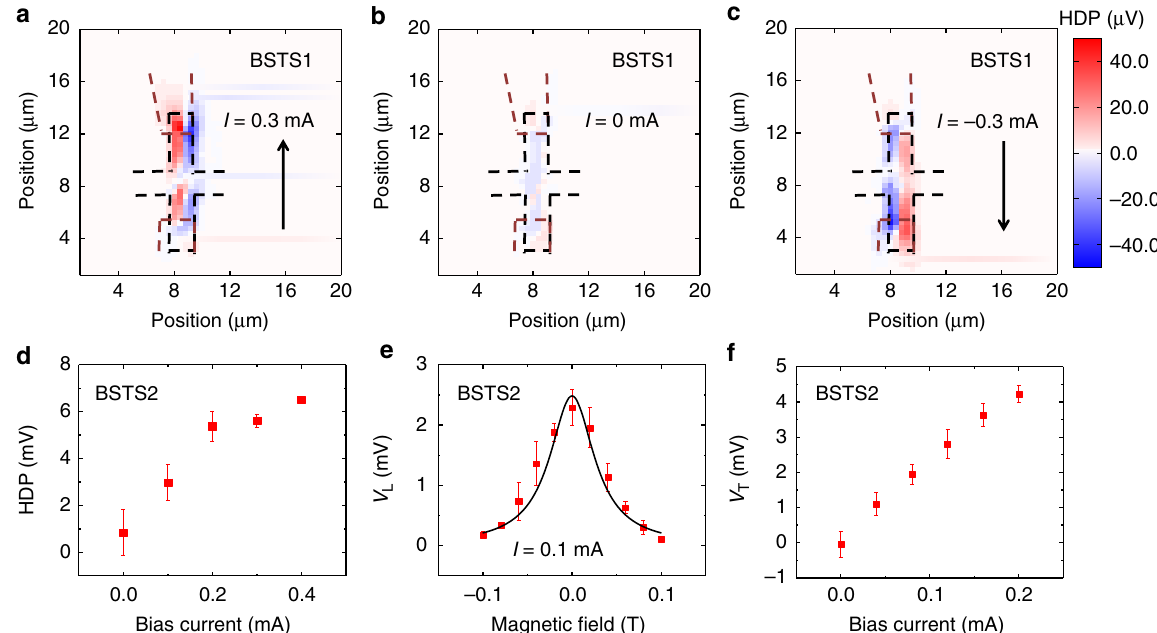
Fig. 4 Current induced spin accumulations in BiSbTeSe 2 . a – c Spatial two-dimensional HDP map in BSTS1 under bias currents of 0.3 ( a ), 0 ( b ), − 0.3 mA ( c ) with I pump = 0.4 mW. Black dashed lines represent the boundaries of the device. Black arrows show the direction of applied bias current. d Bias current dependence of V L by fi xing the laser spot at one edge of the device in BSTS2. e Measurement of HDP at one edge as a function of B ext in BSTS2. f Bias current dependence of V T by fi xing the laser spot at the center of the Hall cross in BSTS2. Solid lines are fi ts. The error bars in d , e , and f are the standard deviation from fi ve